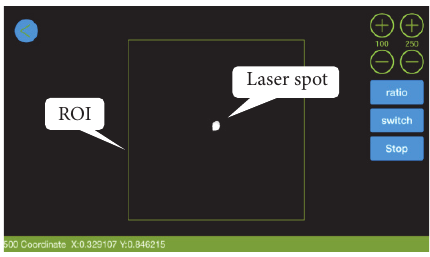
Figure 2: Monitoring interface.